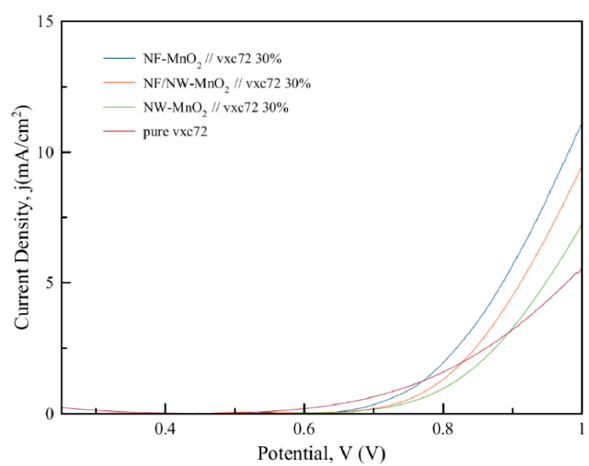
Figure 6. Linear sweep voltammetry curves for OER at 1600 rpm from 0.2 V to − 1.0 V at the scan rate of 5 mV / s. (vxc72: Vulcan XC 72). Table 1. Onset potential and overpotential for all the catalysts and pure carbon Vulcan XC 72. Sample Onset Potential at 5 mA/cm 2 , V Overpotential, V